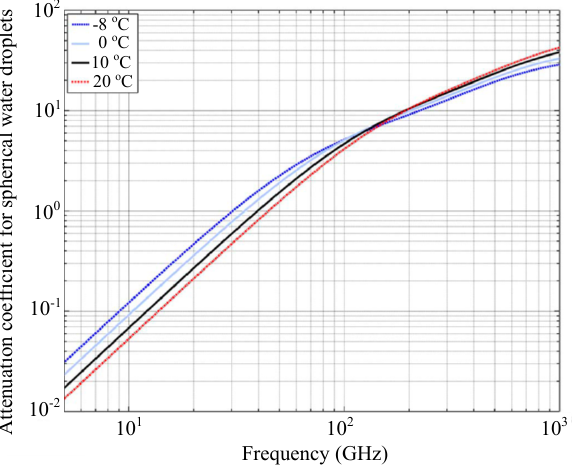
Figure 1. Attenuation coefficient for spherical water droplets at several temperatures.